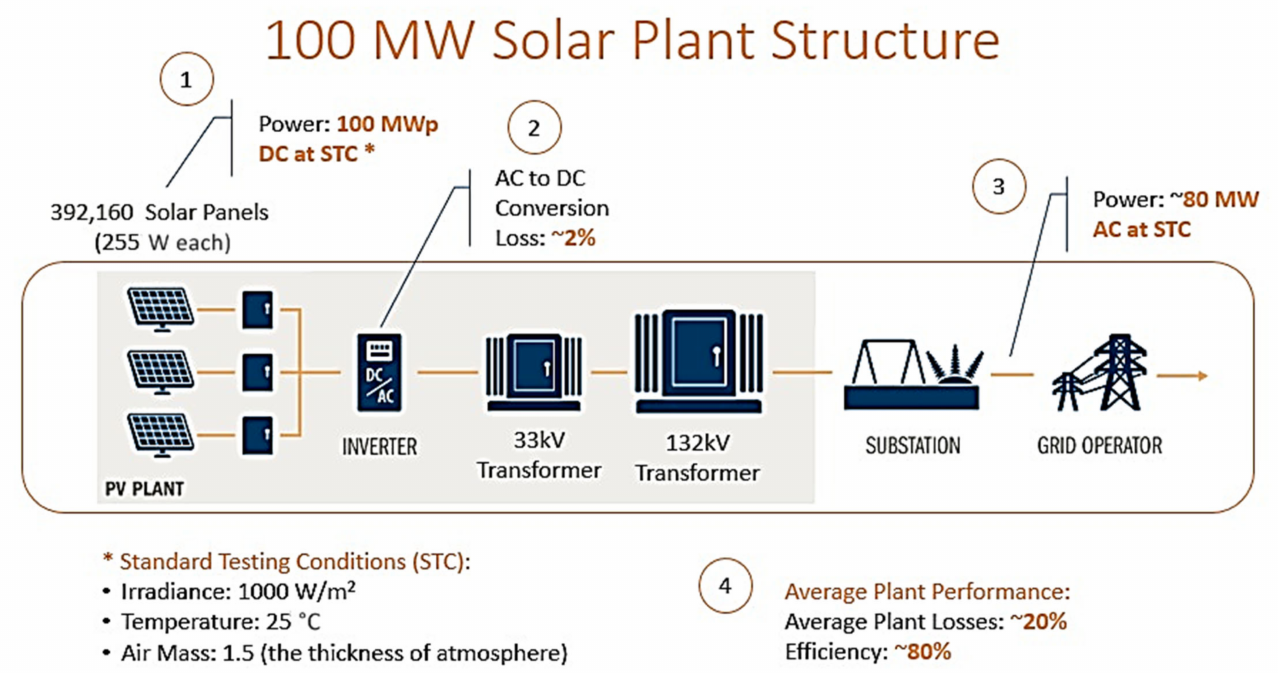
Figure 2. The 100 MW Quaid-e-Azam Solar Park structure. (* Standard Testing Condition depends upon irradiance, temperature and the thickness of atmosphere) [10].